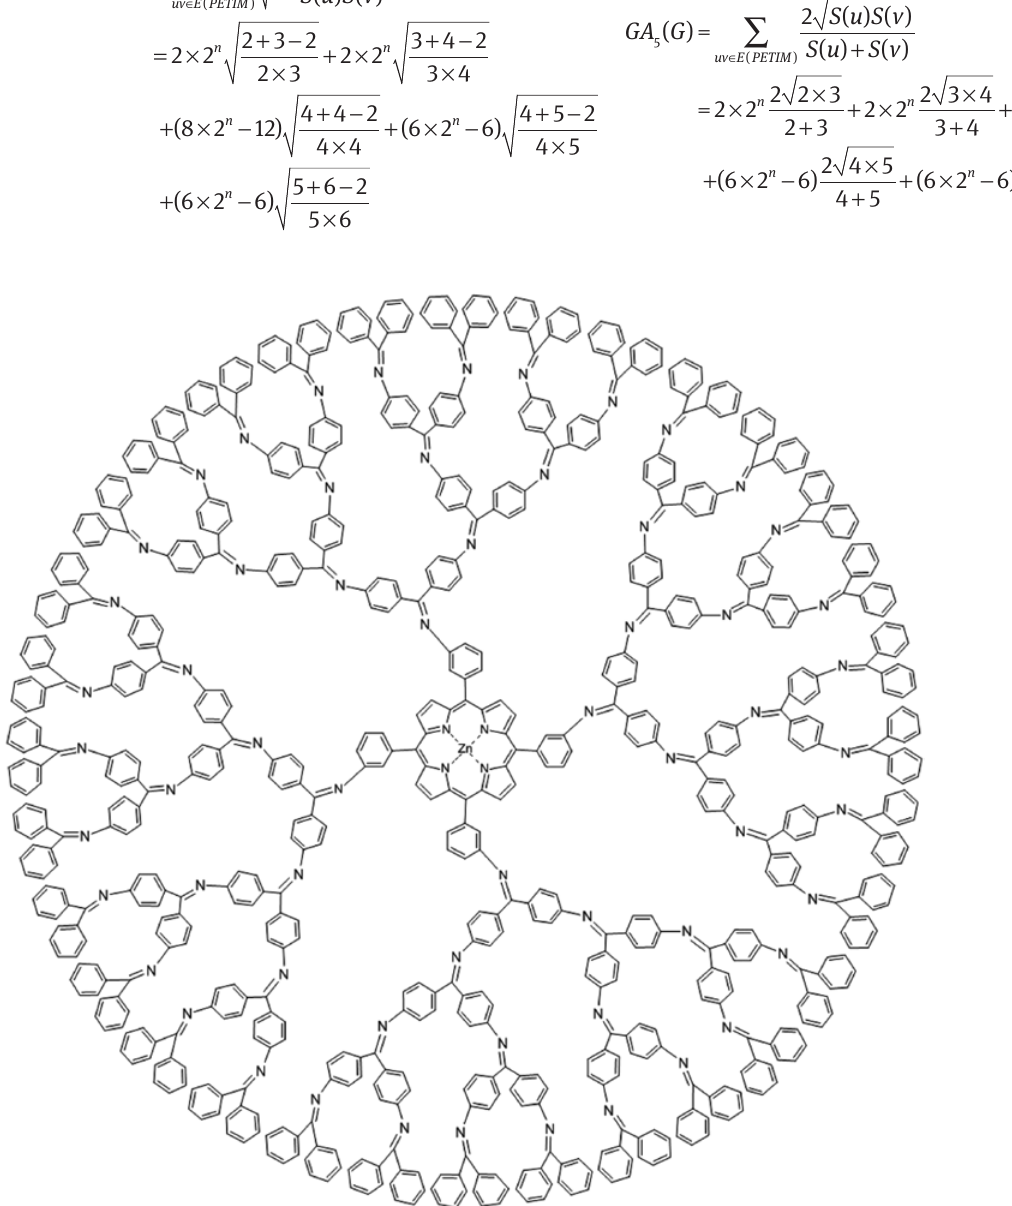
Figure 2: Molecular graph of zinc porphyrin dendrimer DPZ